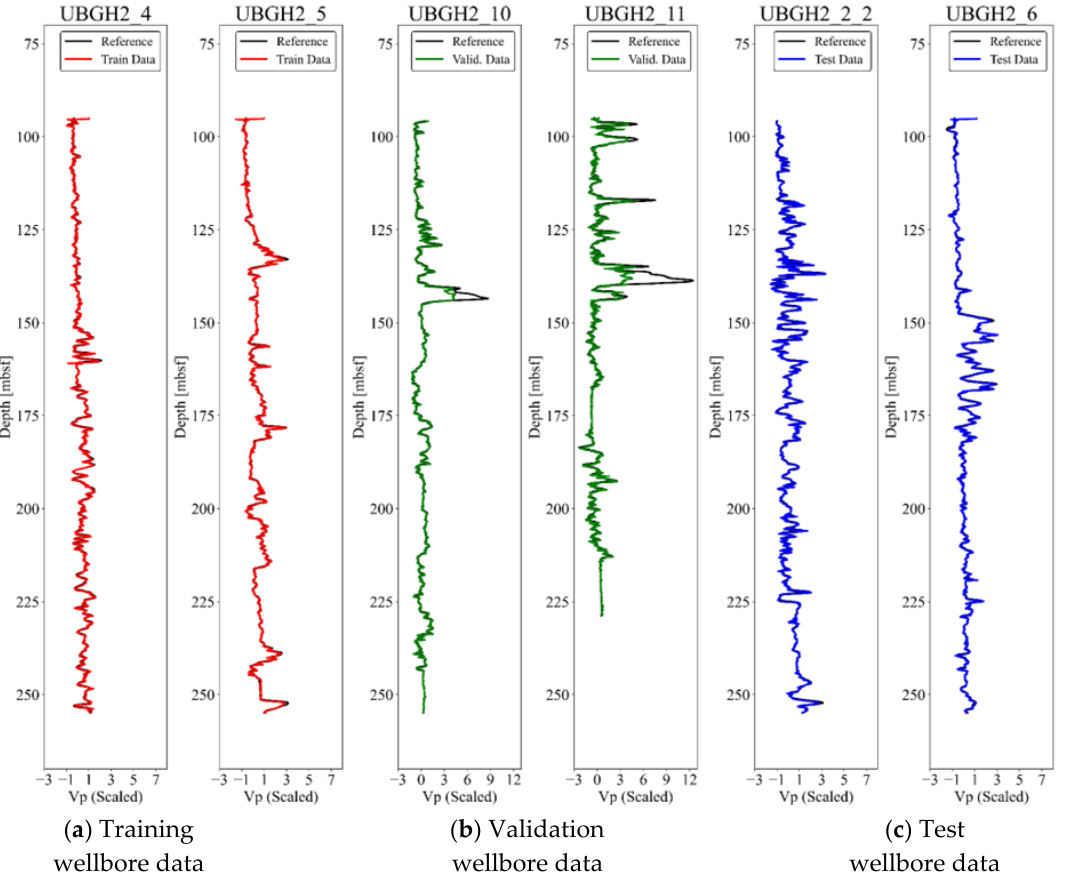
Figure 12. Comparison of synthetic and reference Vp profiles in the UBGH2 field: ( a ) training wellbore data (red curves), ( b ) validation wellbore data (green curves), and ( c ) test wellbore data (blue curves).